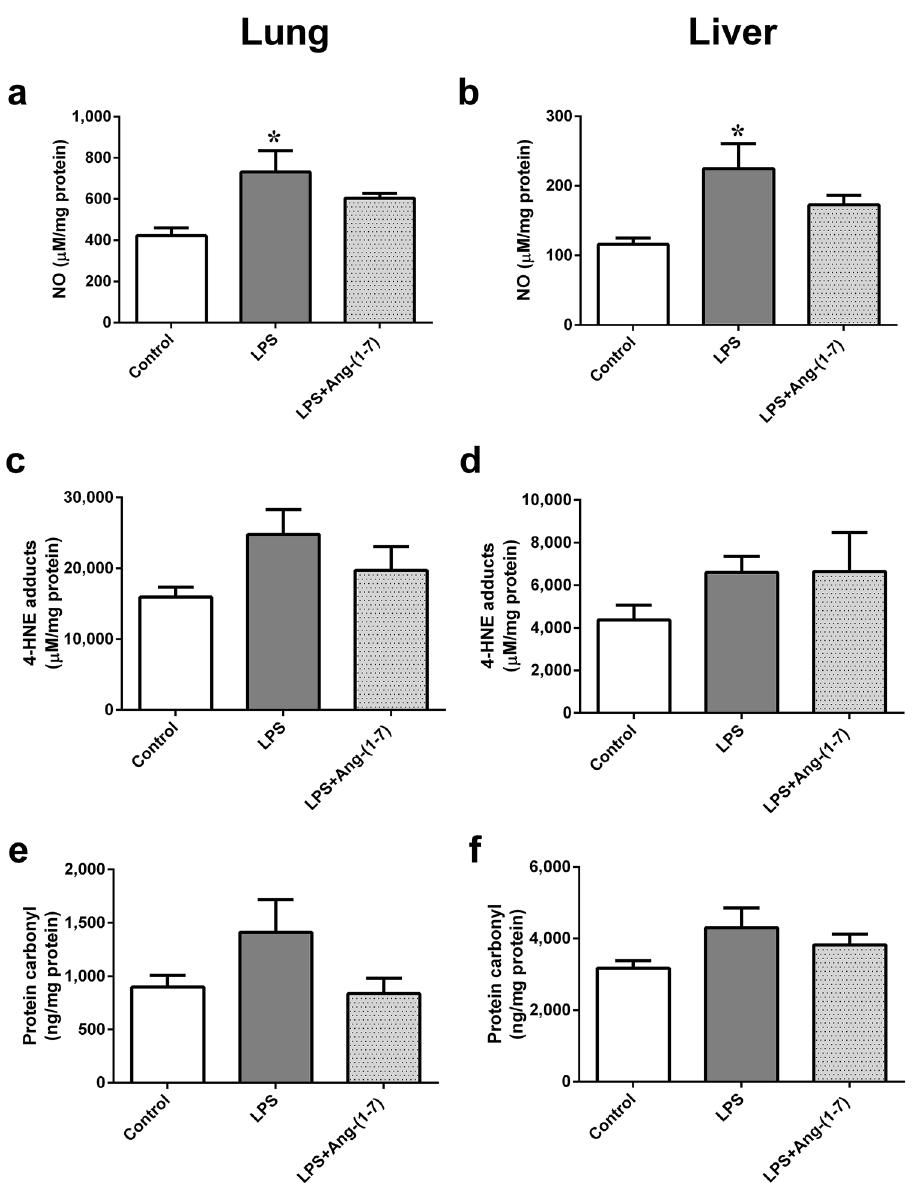
Figure 5. Effect of Angiotensin-(1–7) on tissue levels of nitric oxide (NO) and oxidative stress in endotoxaemic rats. We assessed the levels of NO ( a , b ), 4-hydroxynonenal (4-HNE) ( c , d ), and protein carbonyl ( e , f ) in lung and liver tissues in rats infused with 0.9% NaCl (control, n = 3), E. coli lipopolysaccharide (LPS, 10 mg/kg for 15 min, n = 3), or LPS plus Ang-(1–7) (1 mg/kg for 3 h at 0.5 h after LPS, n = 3). Lung and liver tissues were harvested 6 h after LPS administration. The data are shown as the mean ± standard error of the mean. *, p < 0.05 for LPS vs.